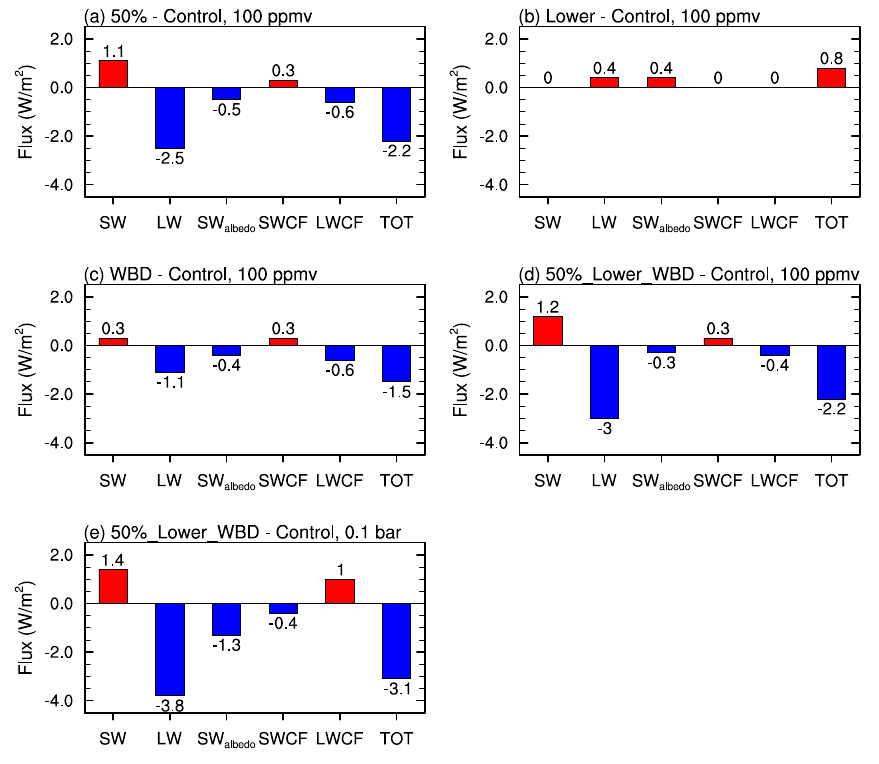
Fig. 8. Changes of surface radiative fluxes in global and annual mean between various ozone scenarios and control experiments. SW is surface-absorbed shortwave flux under clear-sky conditions, excluding the influence of snow-albedo feedback (SW albedo ). LW is surface downward longwave flux under clear-sky conditions. SWCF and LWCF are surface cloud radiative forcing in the shortwave and longwave bands, respectively. TOT is the sum of SW, LW, SW albedo , SWCF and LWCF. CO 2 concentration is 100ppmv in (a–d) and 0.1bar in (e) .